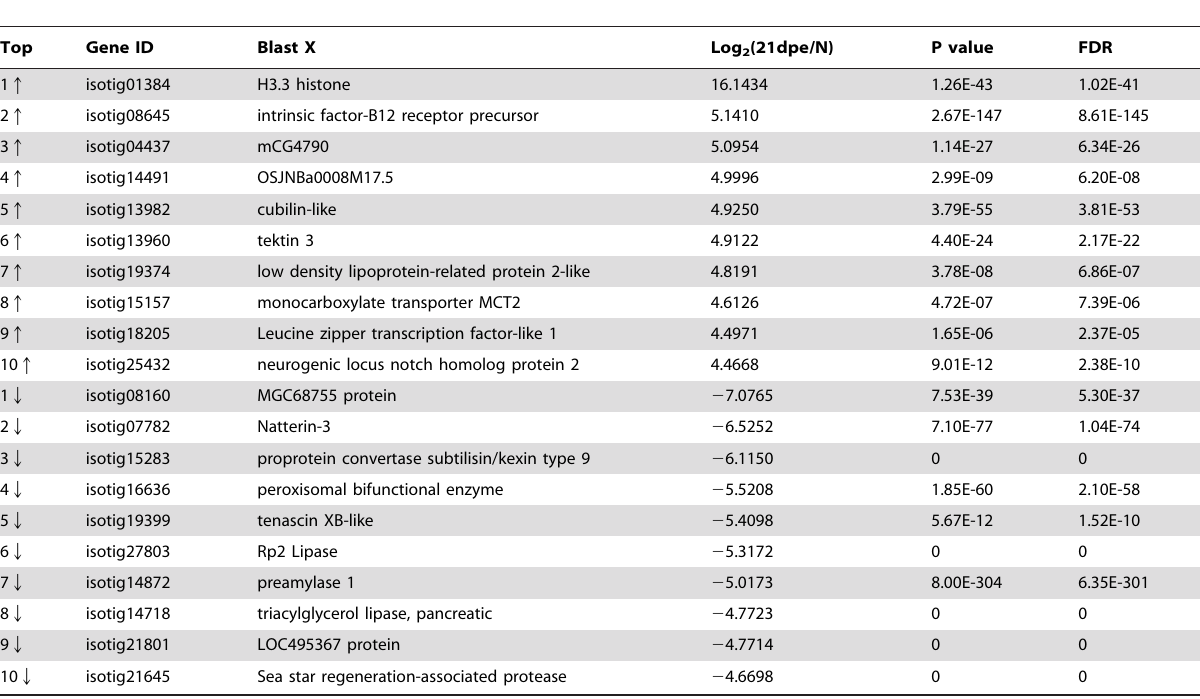
Table 5. Top 10 differentially expressed genes at 21 dpe VS